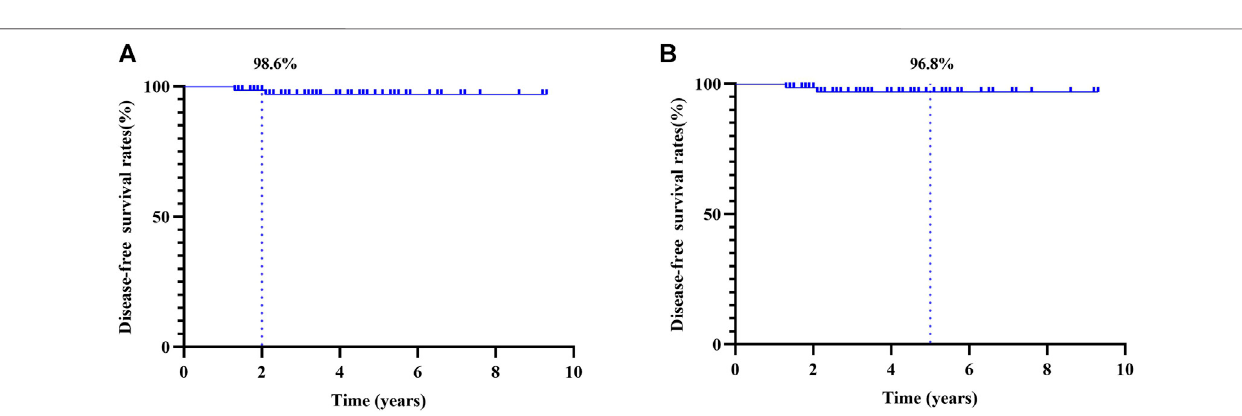
DFS Severe LVEF absolute follow-up CHF/CD decline from times